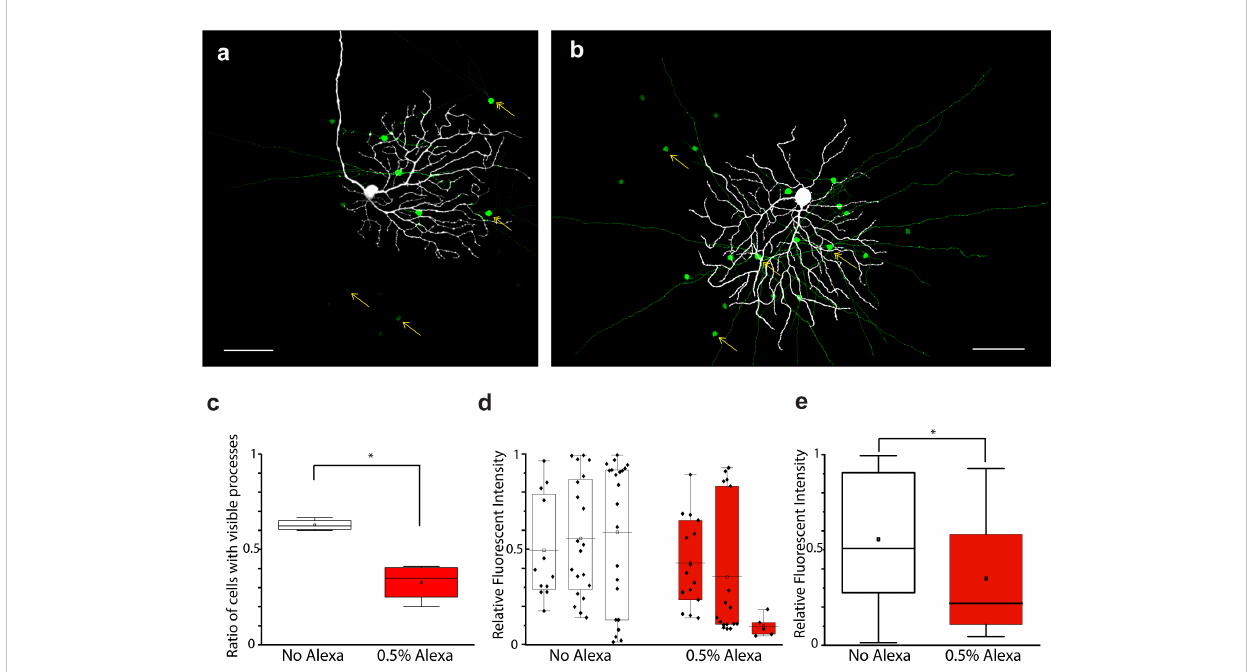
FIGURE 3 Interference in the diffusion of tracers/dyes injected simultaneously in the OFF alpha RGC array. (A, B) Images showing the results of OFF alpha RGC NB injections with (A) and without (B) Alexa568 (0.5%) in the internal solution. (C) Diagram displaying the ratio of coupled ACs and showing P (compared with the total number of coupled AC somata in the corresponding injection) with or without Alexa568 in the internal solution. Statistical analysis showed a signi fi cant ( p < 0.05; asterisk) difference in the number of coupled ACs with or without Alexa568 in the pipette. (D) Diagram showing the relative brightness of coupled AC somata in 3 + 3 NB-injected OFF alpha RGC arrays with or without Alexa568. (E) Summary diagram showing the averaged brightness of coupled ACs of the 3 + 3 tracer injections shown in panel (D) Statistical analysis revealed a signi fi cant ( p < 0.05; asterisk) difference in brightness between ACs with and those without Alexa568 in the pipette. Scale bar: 50 m